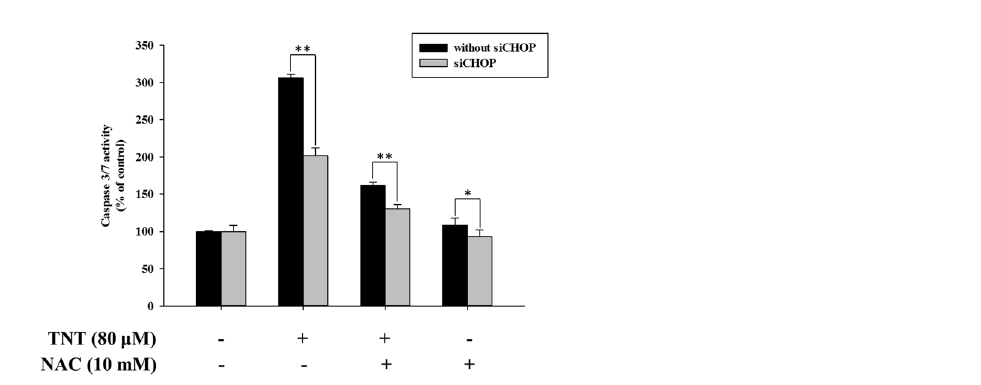
Figure 6. Effects of CHOP siRNA on TNT-induced ER stress in HepG2 cells. The cells were transfected with or without CHOP siRNA and treated with or without TNT (80 μ M) and with or without NAC for 24 h. Caspase-3/7 activity was detected via microplate reader. The data are presented as mean ± SD for four independent experiments with triplicate determinations. * P < 0.05; ** P < 0.01 as compared with